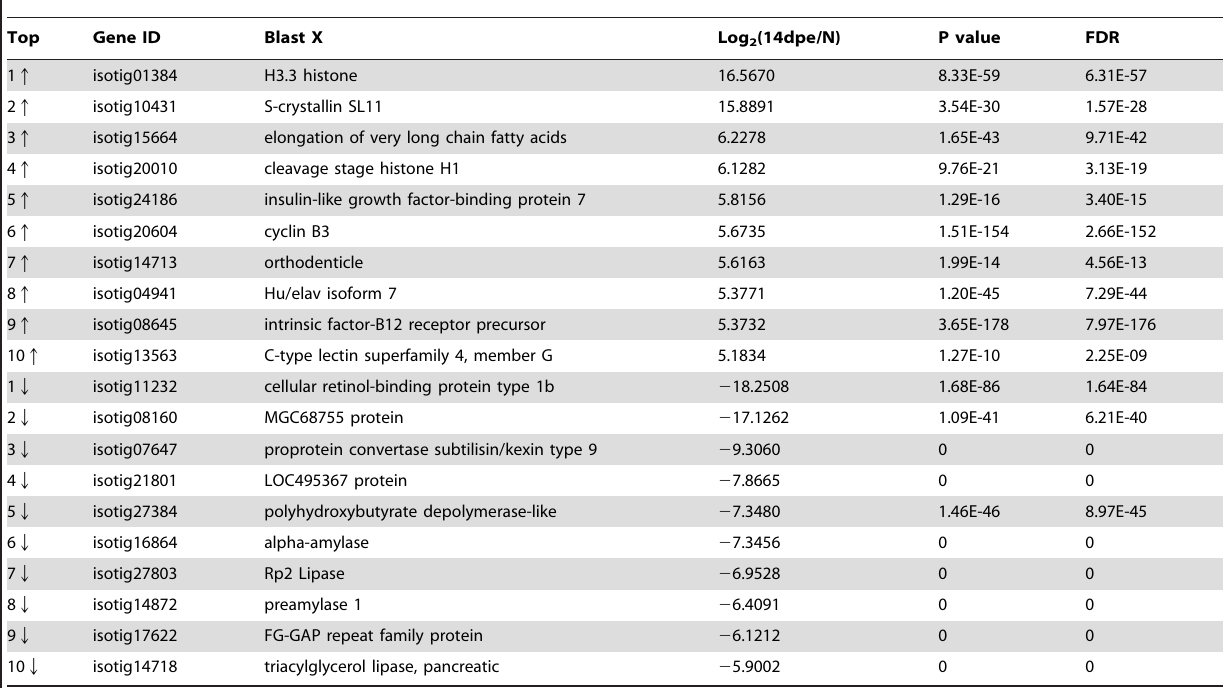
Table 4. Top 10 differentially expressed genes at 14 dpe VS Normal.